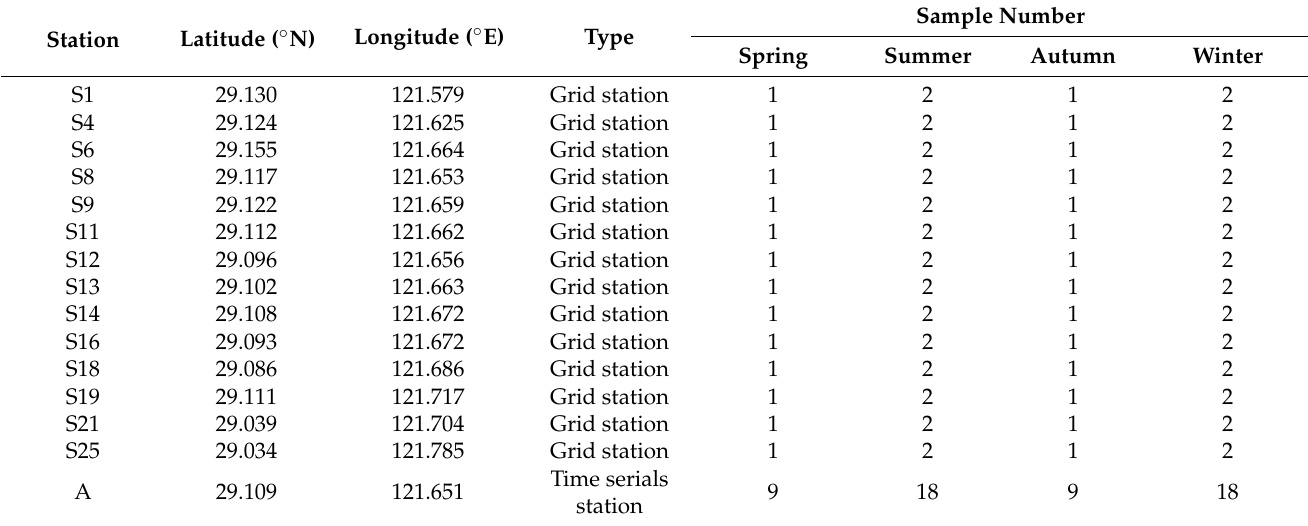
Table 1. Location parameters of phytoplankton net sampling stations in Sanmen Bay from 2016 to